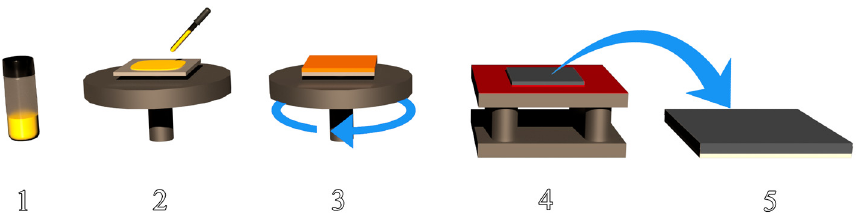
Figure 6. Schematic illustration of the perovskite thin film preparation: 1—dissolution of CH 3 NH 3 PbI 3-x Cl x , 2—application of 50 µ L solution to the substrate, 3—spin coating at 1000 rpm for 30 s, 4—annealing at 100–120 ° C for 100 min, 5—resulting perovskite sample.